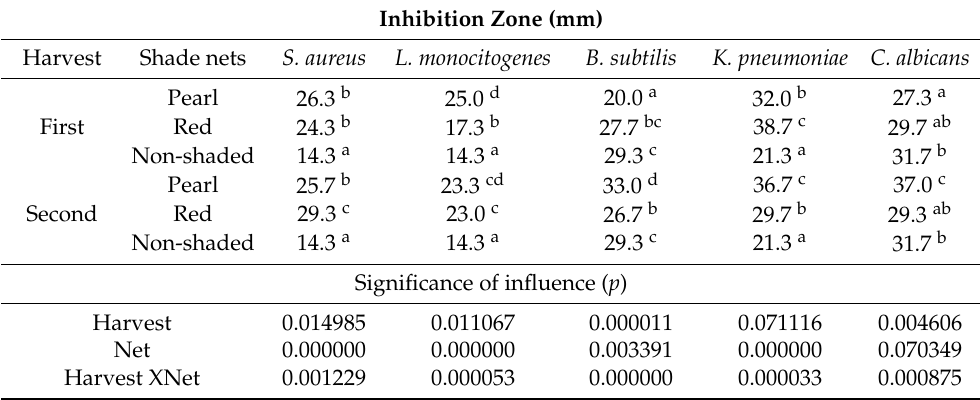
Table 5. Influence of harvest time and shading with pearl and red nets on antimicrobial activity of